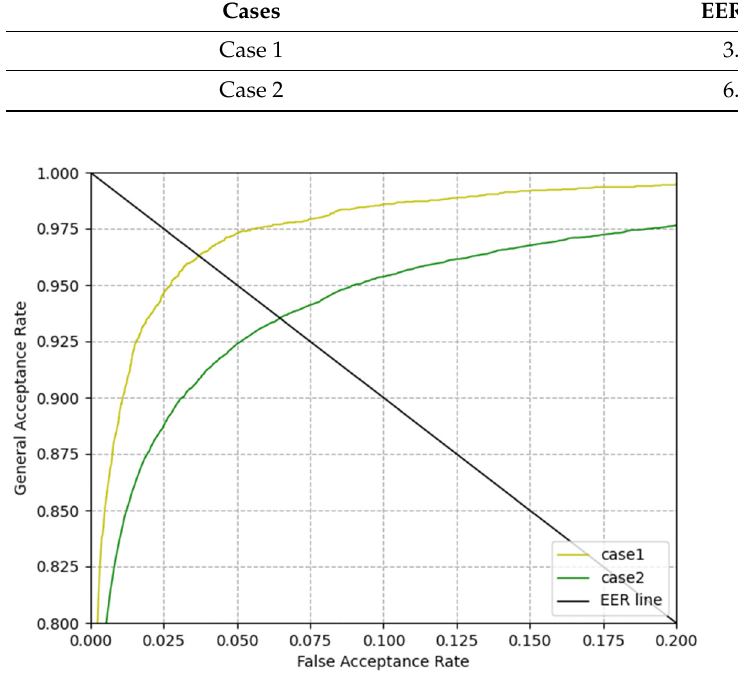
Figure 9. ROC curves of ocular recognition based on cross-database matching.